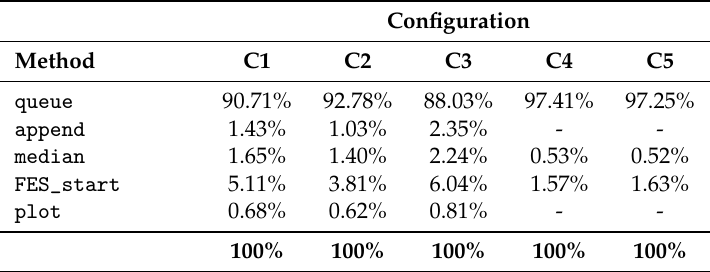
Table 2. Time profiling results for the evaluation of the methods breakdown during the FES current definition process.